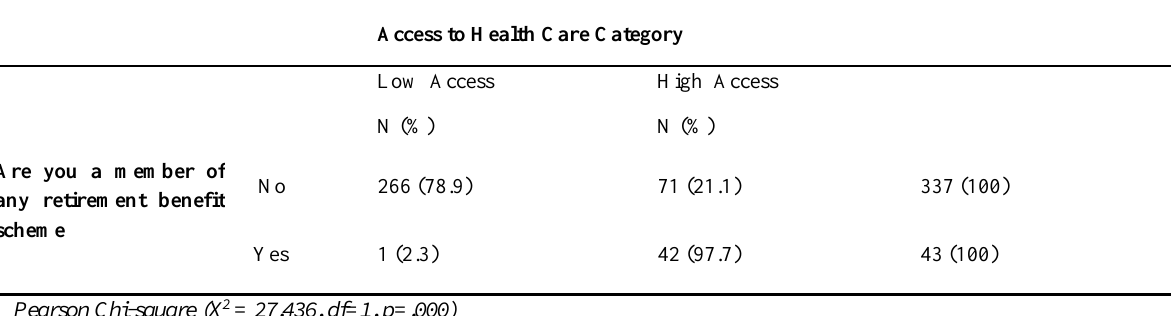
Table 8: Cross Tabulation of Retirement Scheme and Access to Health